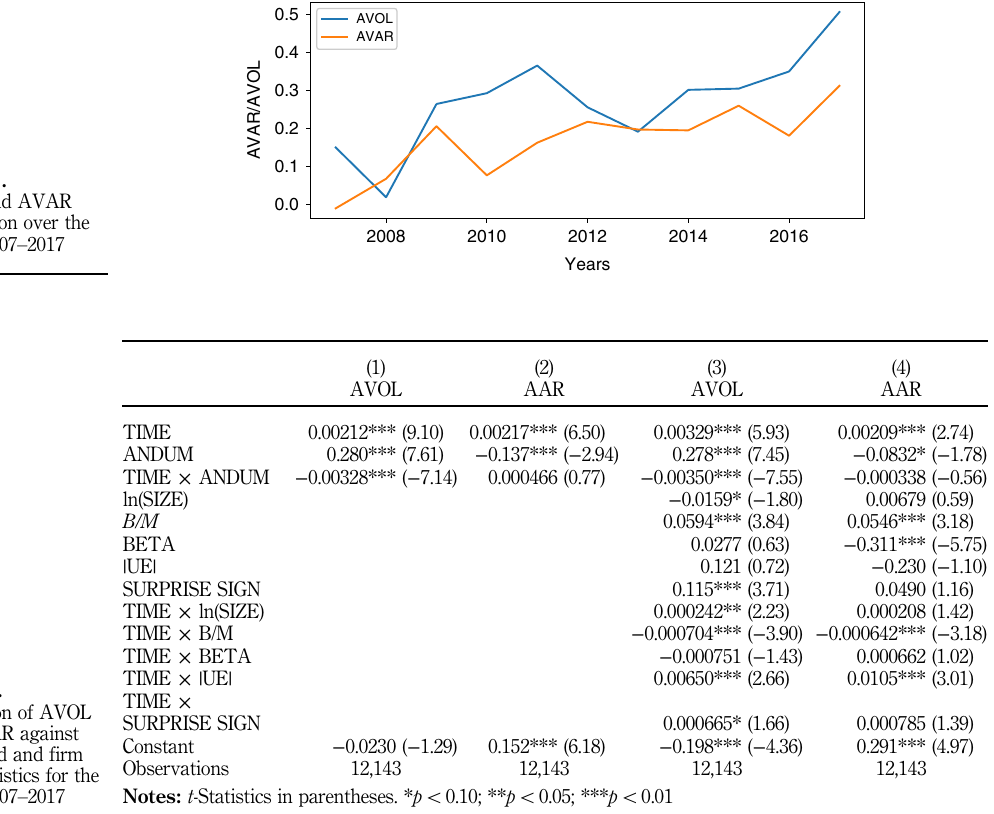
Figure 1. AVOL and AVAR